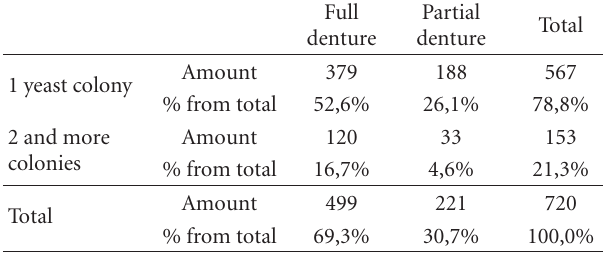
Table 10: Distribution of number of yeasts colony according to the type of denture.